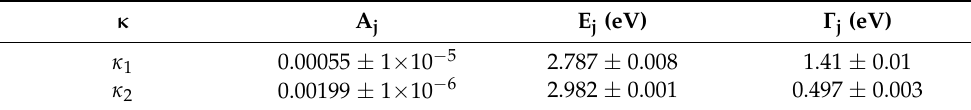
Table 2. Gaussian parameters for κ (offset κ 0 = − 6.64 × 10 − 4 ± 4 × 10 − 6 ) in Equation (5).